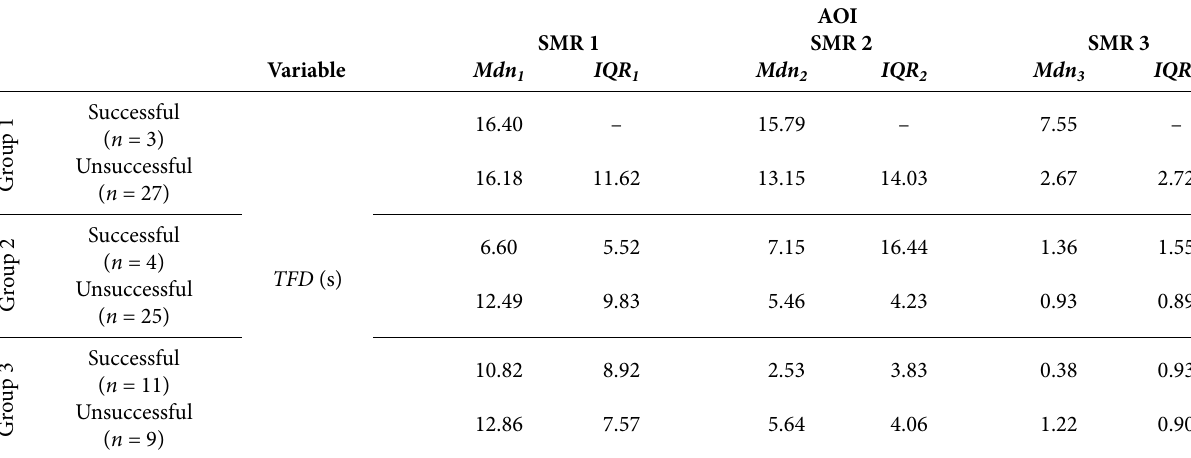
Table 3. Median (Mdn) and interquartile range (IQR) of TFDs on areas of interest for successful and unsuccessful students of 3 age groups for Task 1 (solid state of water). The correct SMR is SMR